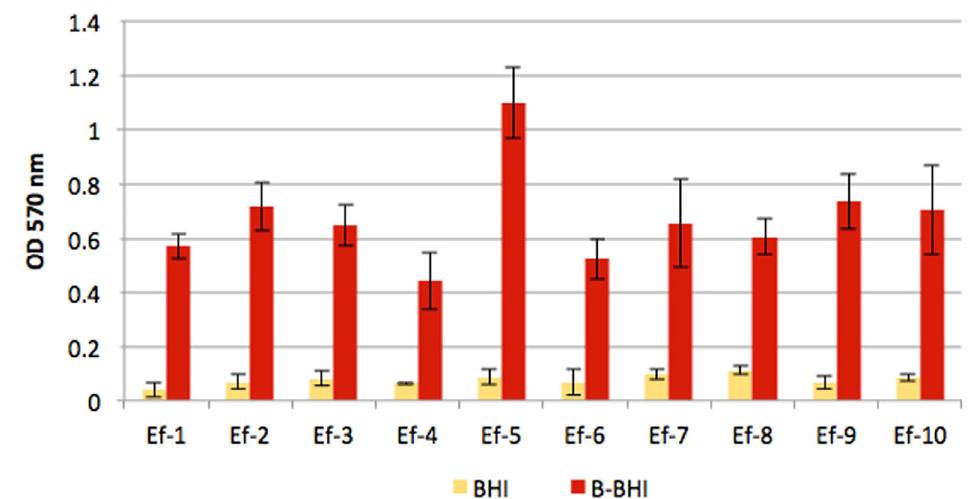
Figure 2. BF production by Ef isolates grown in BHI and in BHI supplemented with 5% defibrinated sheep blood (B-BHI). Each strain was always tested in triplicate and final results are the means of three independent experiments ± standard deviation.